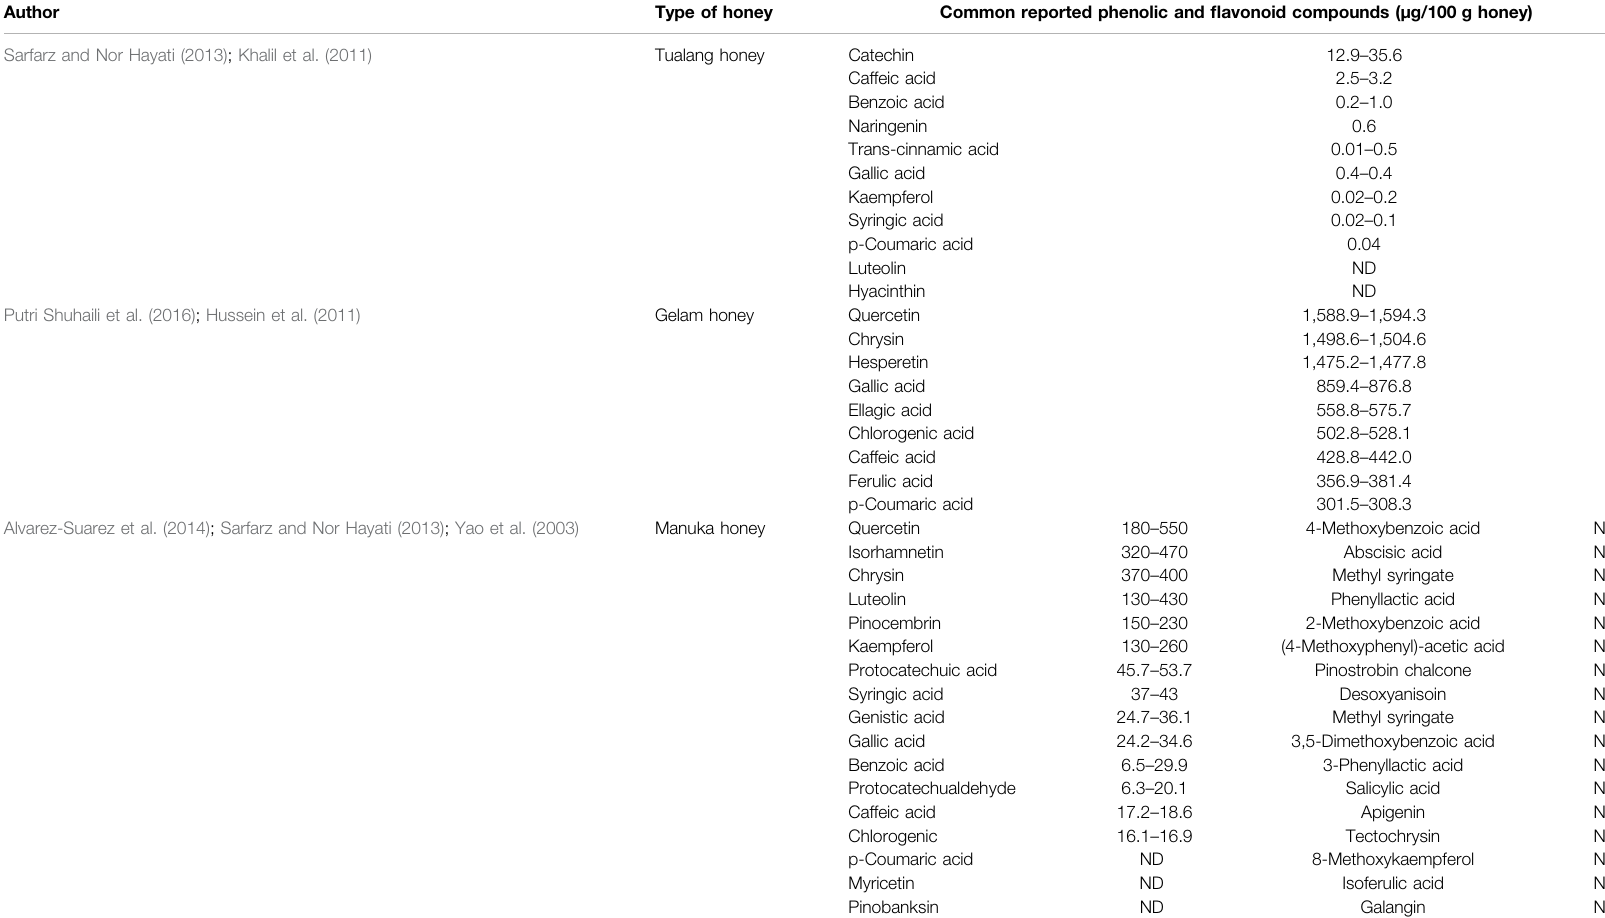
TABLE 1 | The common reported phenolic and fl avonoid compounds found in Tualang, Gelam, and Manuka honey as well as each of their respective quantitative data. design and study outcome of